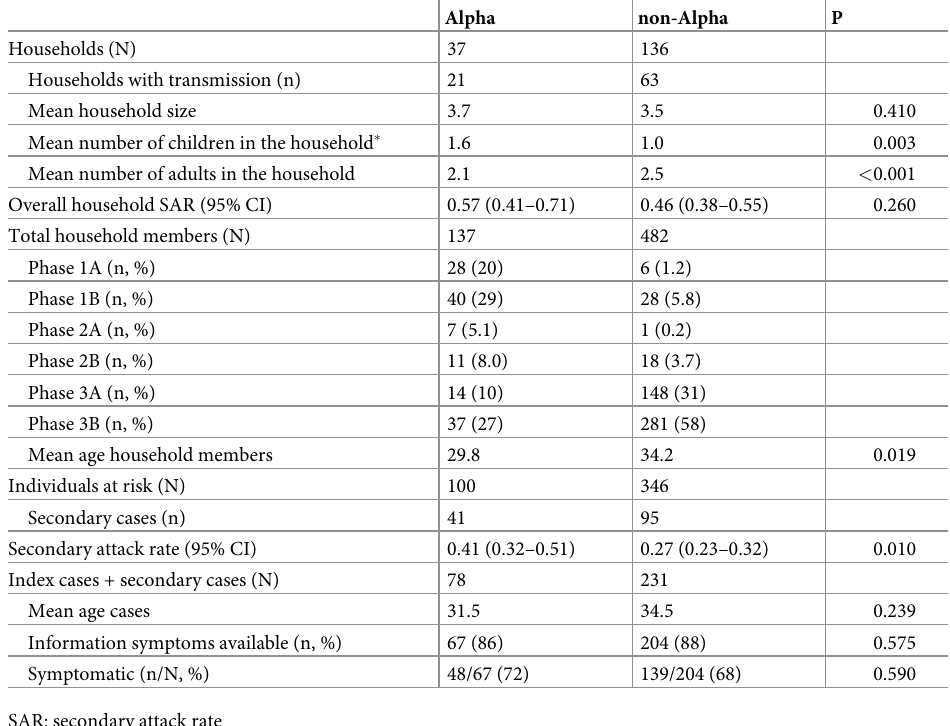
and 256 of 351 (73%) non-Alpha infected cases reported to be symptomatic (no significant dif- ference, p = 0.449). The mean number of reported symptoms was 2.1 and 2.3 for respectively Alpha and non-Alpha infected symptomatic cases (p = 0.442). Stratification of the analysis by age group did not show significant differences in reported clinical symptoms among age groups (S2 Material). Households with prospectively tested cases and for whom variant typing could be done were selected to determine the household secondary attack rate (Table 2). The mean age among household members with infection(s) with the Alpha variant was significantly younger compared to household members with non-Alpha variant infection(s) (p = 0.019). There were significantly more children in the households infected with the Alpha variant (p = 0.003) and significantly more adults in non-Alpha infected households (p < 0.001). Of 100 individuals at risk in Alpha variant infected households, 41 (41%, 95% confidence interval (CI) 32%-51%) individuals became infected, and 95 of 346 (27%, 95% CI 23%-32%) individuals at risk in non- Alpha variant infected households became infected; a 52% higher transmission among con- tacts in Alpha variant infected households (p = 0.010). Table 2. Characteristics of households and household members infected by Alpha versus non-Alpha